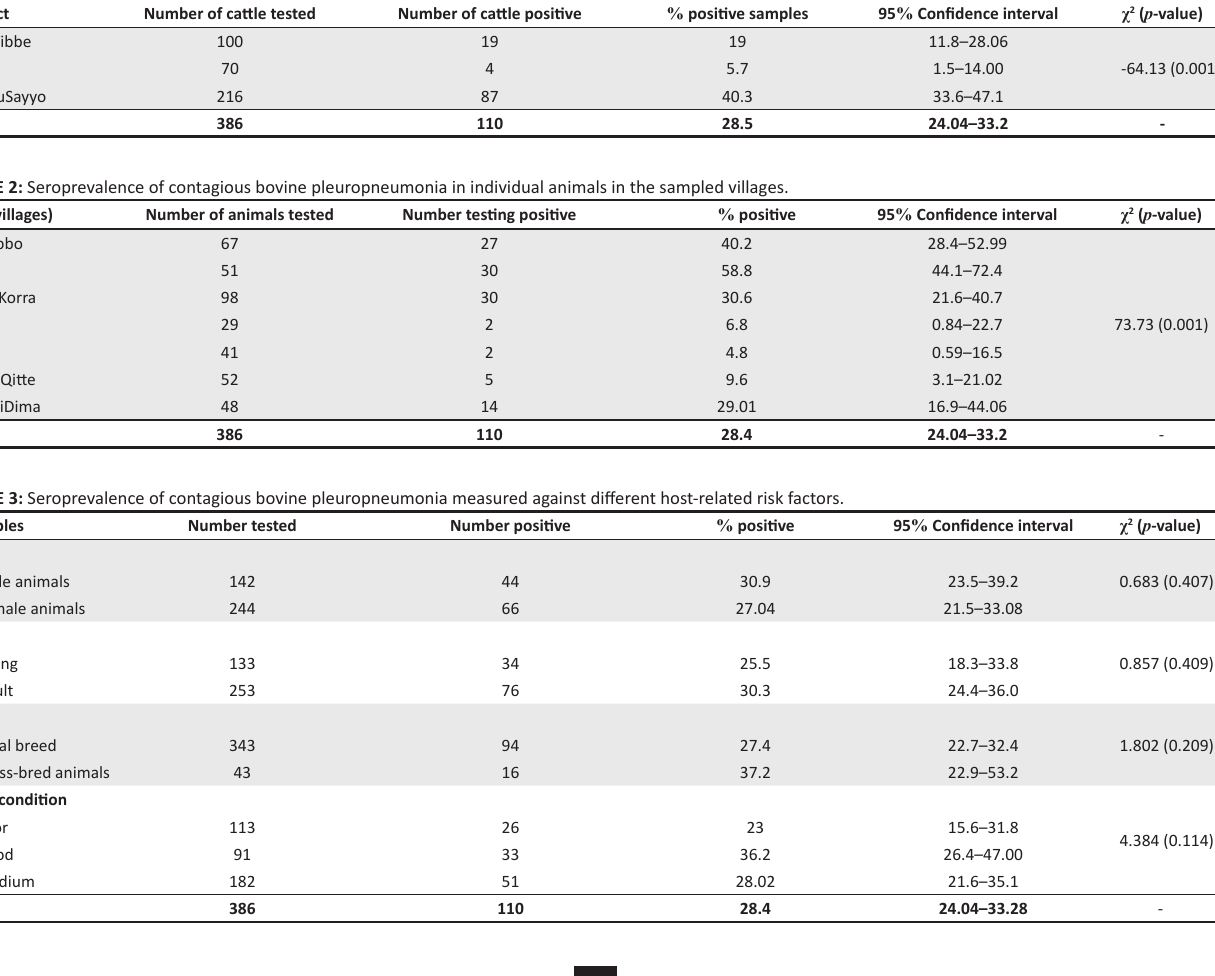
TABLE 1: Seroprevalence of contagious bovine pleuropneumonia in individual animals in the western part of Oromia, Ethiopia. District Number of cattle tested